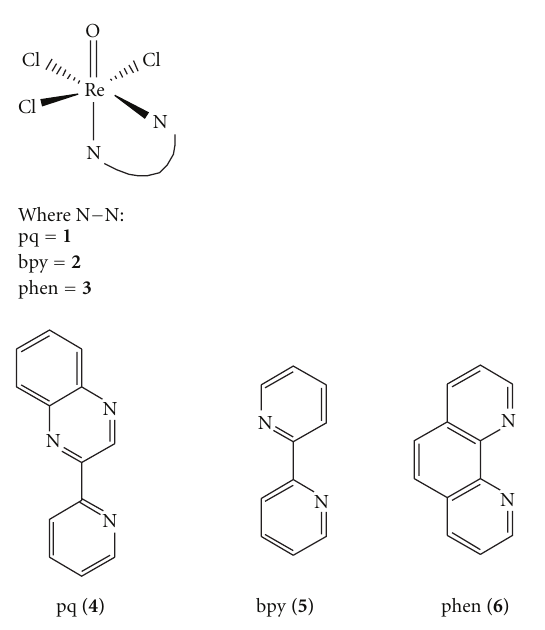
Figure 1: Structures of the complexes 1 – 3 and the corresponding α -diimine ligands.